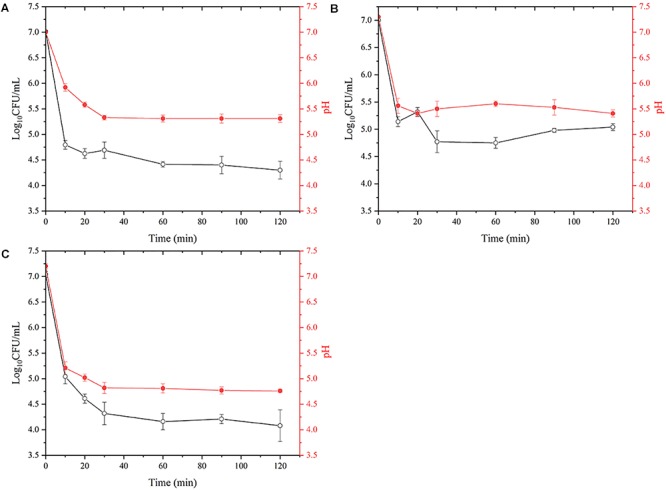
The effect of simulated gastric fluids treatment on the decrease of viable V. parahaemolyticus (VPD58) cells in salmon (A), oyster (B), and shrimp (C) and the change of pH.